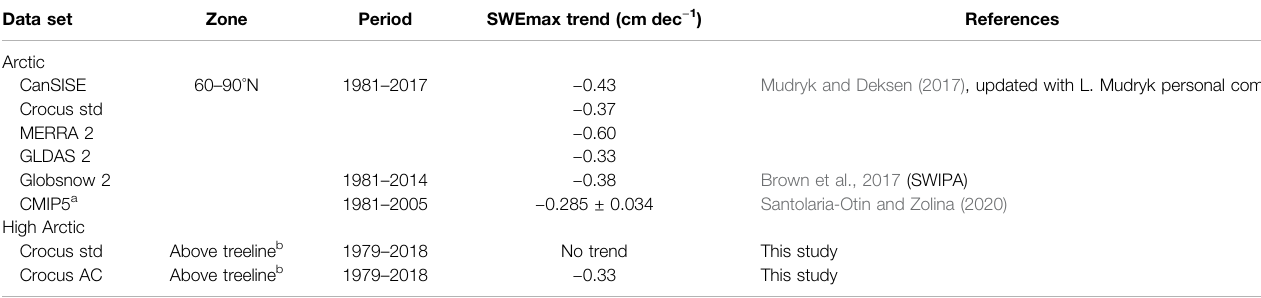
TABLE 7| SummaryofArctictrends insnowwaterequivalent (cm decade − 1 )estimated atthetime ofthewintermaximum (SWEmax)fordifferentgriddeddatasets covering a period of at least 25 years. CanSISE is an observation-based ensemble of gridded daily SWE products from satellite retrievals (Globsnow 2), land surface assimilation systems (GLDAS 2), physical snow models (Crocus v7), and reanalyses (MERRA2 and ERAi) (see Mudryk et al., 2015). CanSISE trend was estimated from the NSIDC CanSISE version 2 dataset (Mudryk and Deksen, 2017) updated for this study. Data